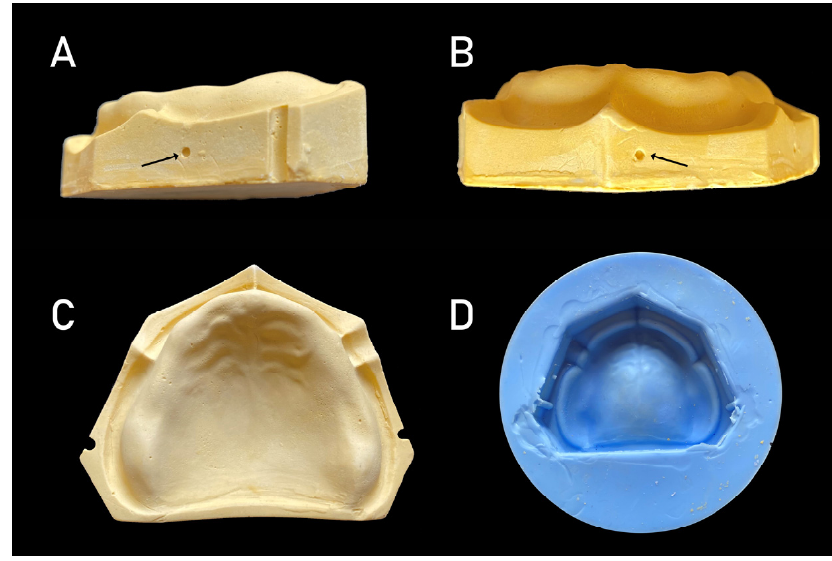
Figure 1. Steps of duplicating cast and teeth setup: ( A , B ) round holes made on cast corresponding to maxillary right central incisor and disto-buccal cusps of the right and left first molars; ( C ) ideal edentulous cast with orientation grooves; ( D ) custom edentulous silicone mold.